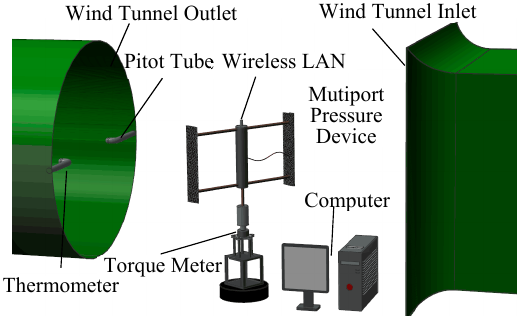
Figure 7. A schematic diagram of Sb-VAWT in the wind tunnel measurement.